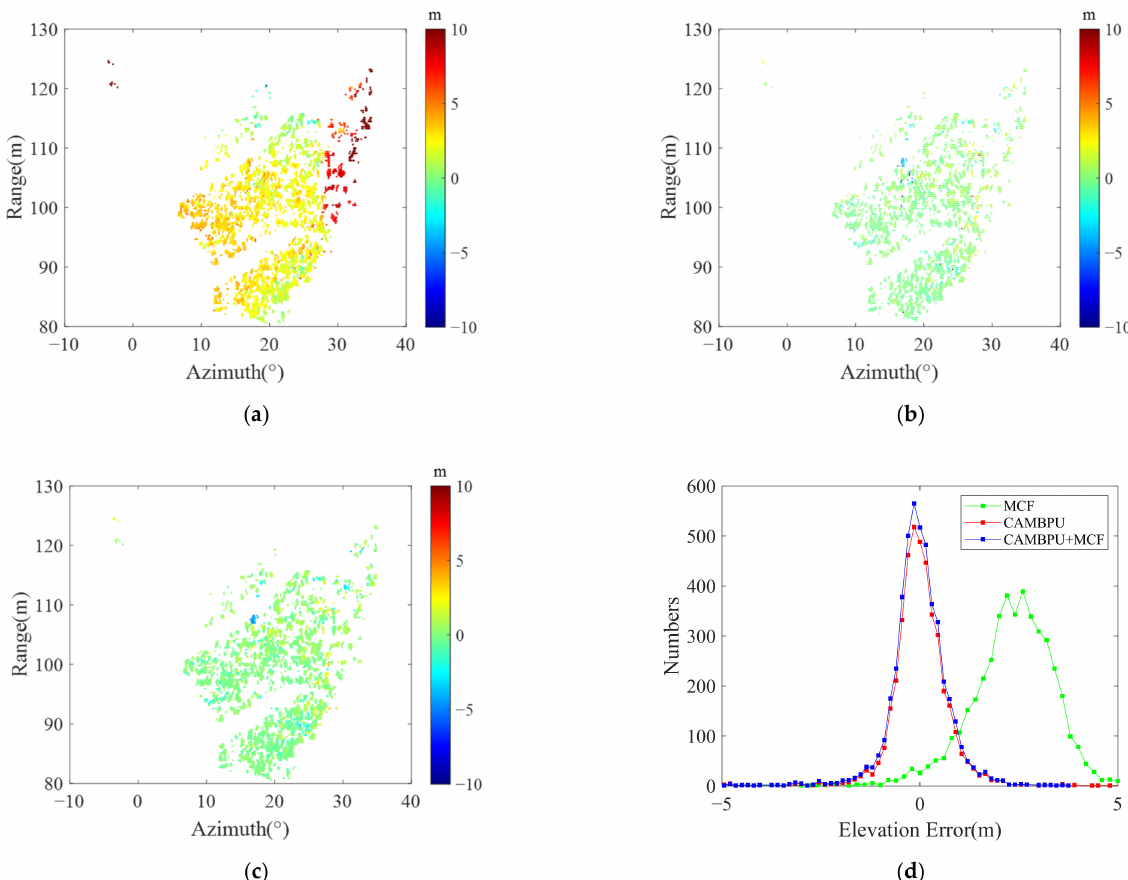
Figure 13. The elevation error distribution of different algorithms. ( a ) MCF. ( b ) CA-based MB PU. ( c ) CA-based MB PU + MCF. ( d ) Error